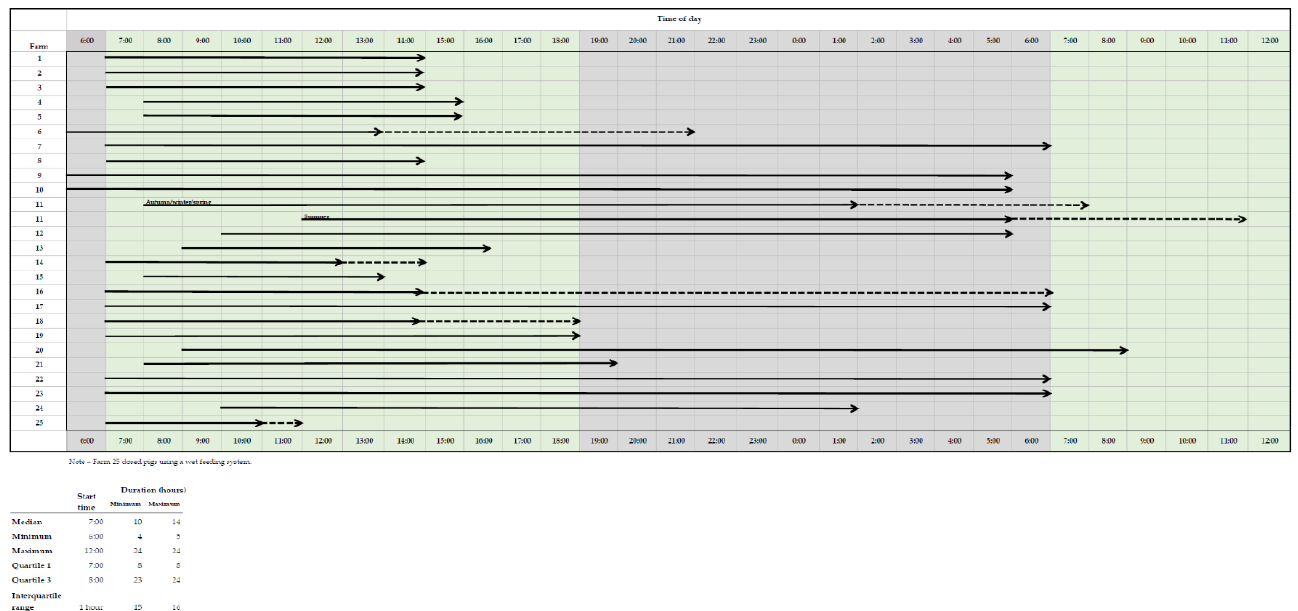
Figure A2. Summary and descriptive statistics for start time and duration of each daily in-water antibiotic dosing event on the 25 pig farms studied.